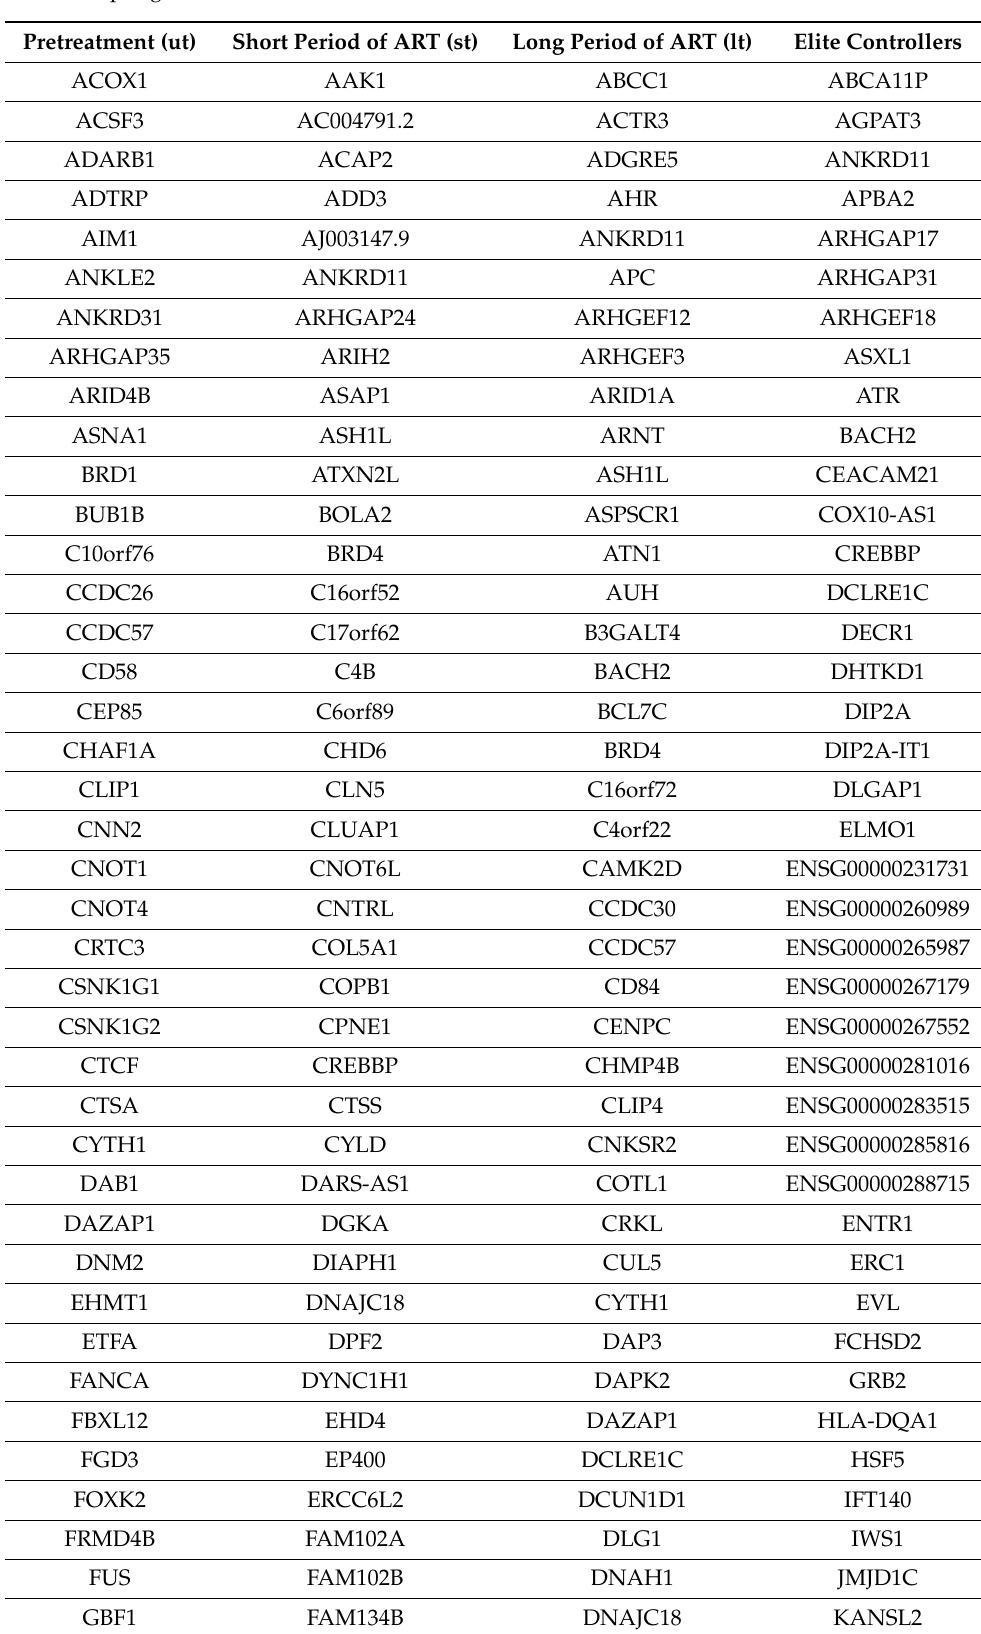
Table 1. Input gene